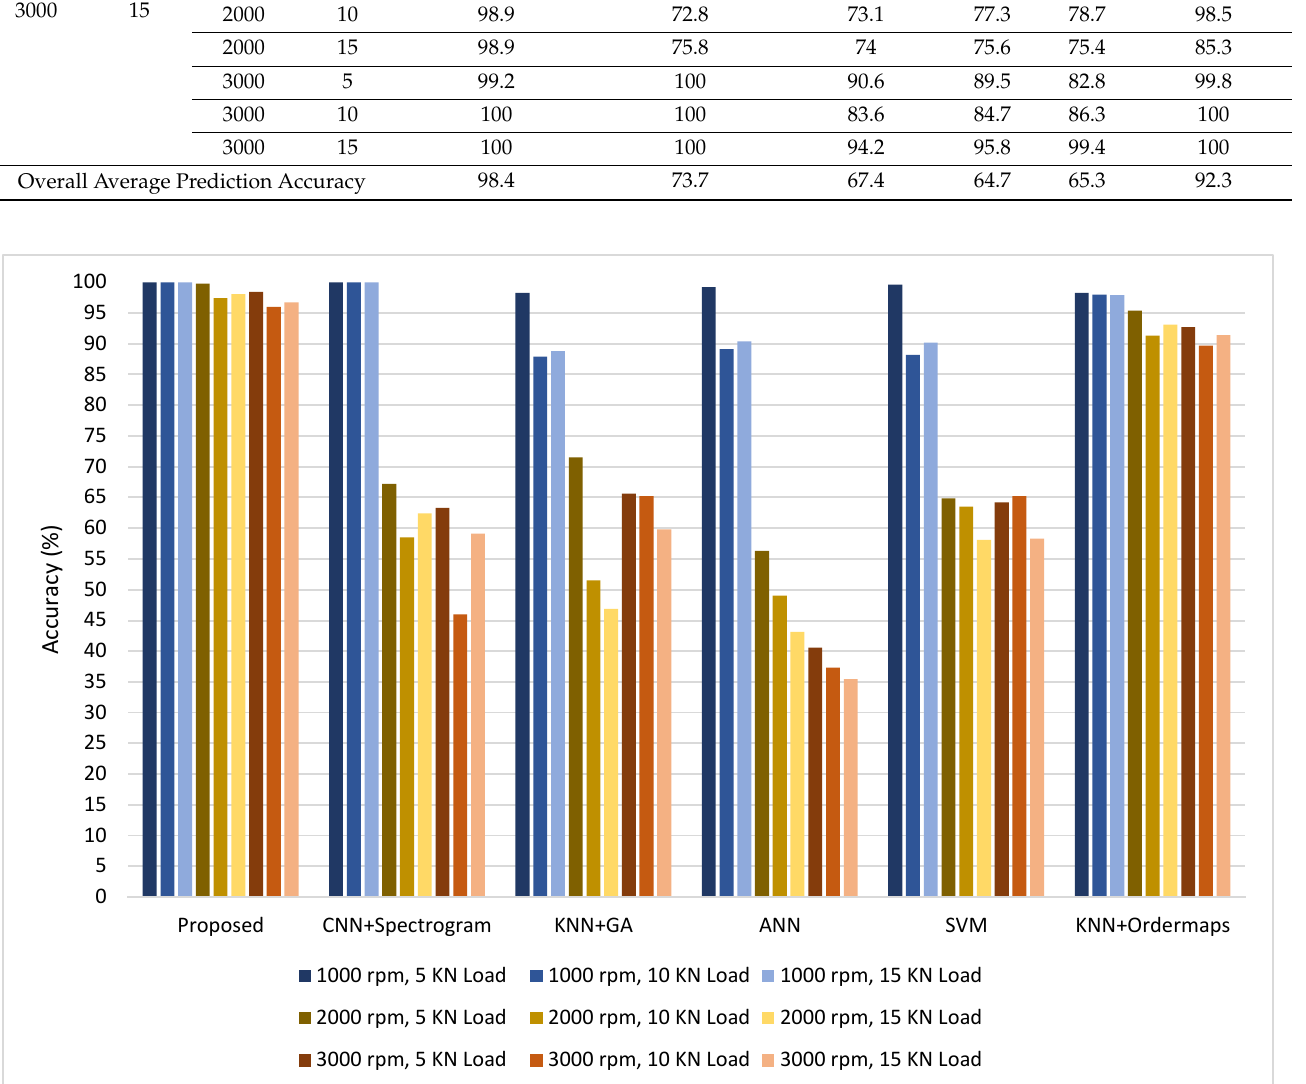
Figure 12. Performance comparison when models were trained at 1000 rpm + 5 KN load and tested under all combinations of speed and load.